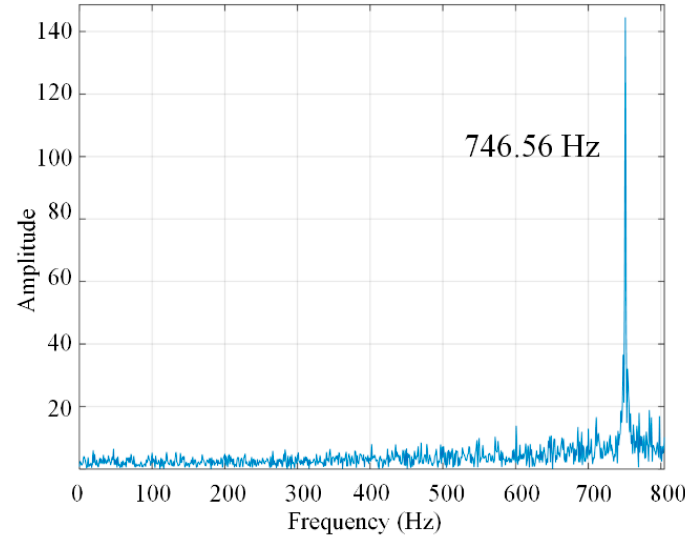
Figure 6. The experimental result of the frequency test.